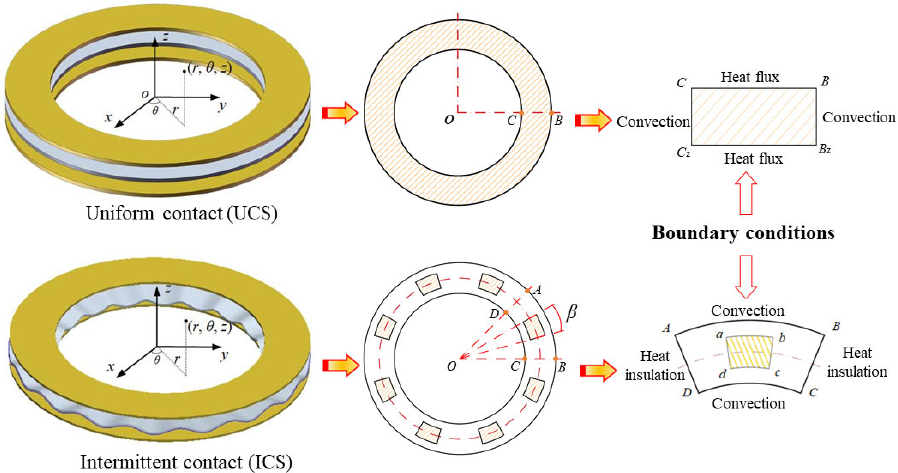
Figure 2. Boundary conditions of friction